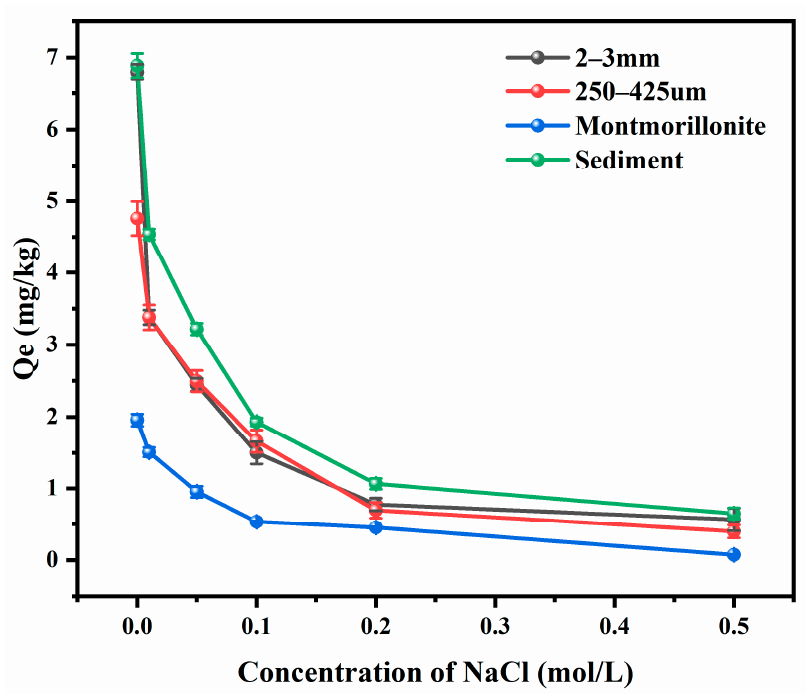
Figure 8. Adsorption of SDZ on different sediments under different salinity at Re =